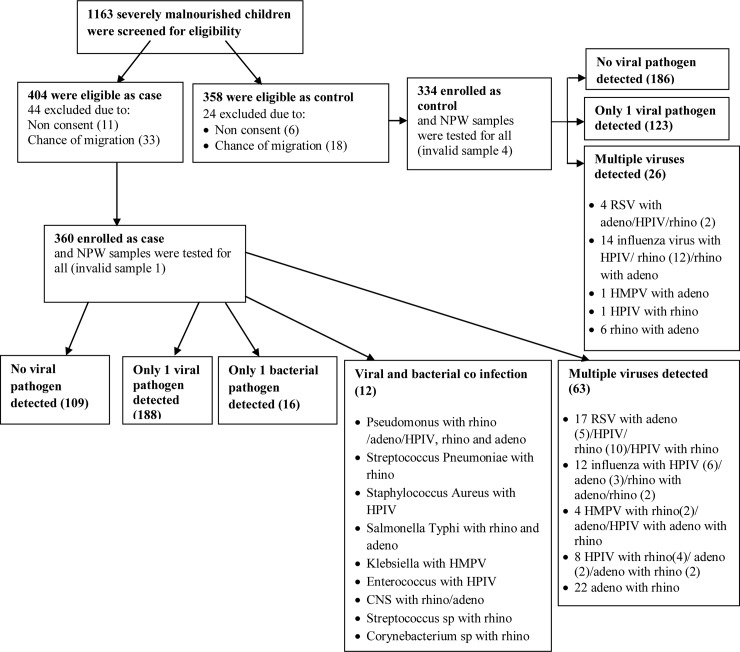
Flowchart on enrolment of study participants and detection of viral and bacterial pathogens.[Abbreviations: NPW-nasopharyngeal wash; RSV- respiratory syncytial virus; HPIV- human parainfluenza virus; HMPV- human metapneumo virus].